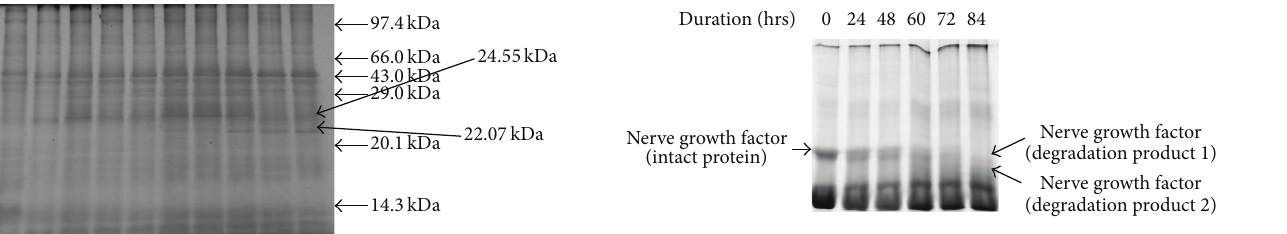
Figure 4: SDS-PAGE for identification of 𝛽 -nerve growth factor in camel semen. Lane 1, 0 hours; lane 2, 24 h; lane 3, 48 h; lane 4, 60 h; lane 5, 72 h; and lane 6, 84